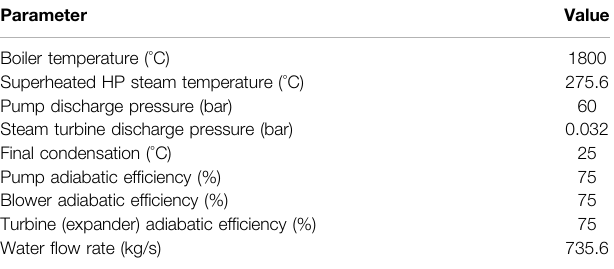
TABLE 2 | Simulation input data of the utility